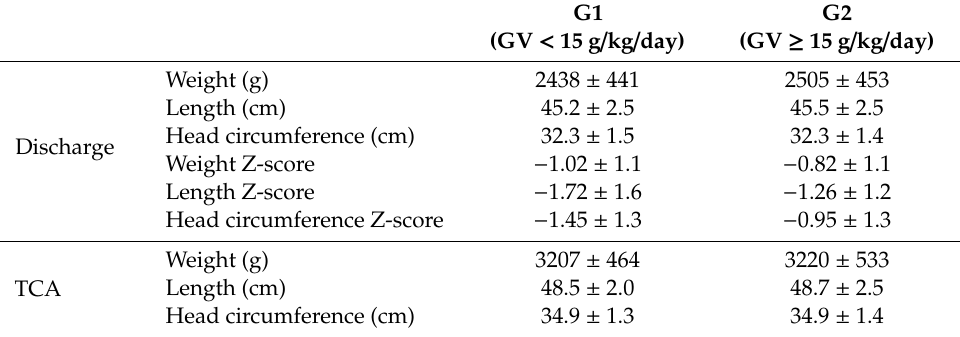
Table 4. Anthropometric measurements at discharge and at term corrected age (TCA).